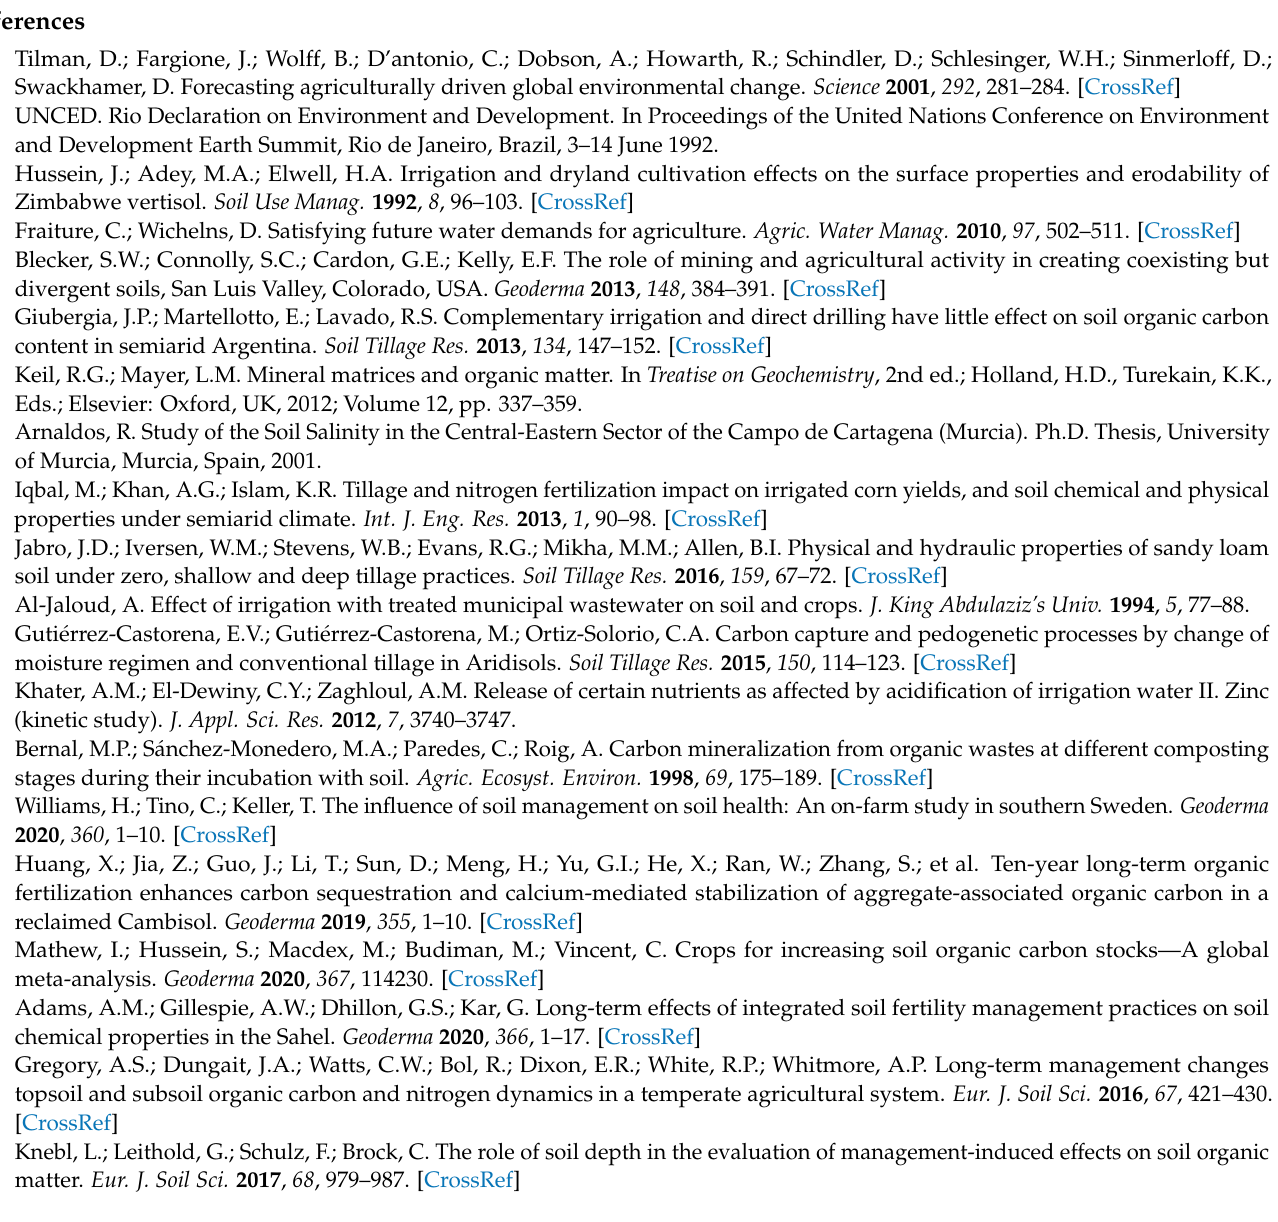
Figure A1. ( A ). Manure not yet decomposed in the Ap1 horizon and mottling of soluble salts (Ap2) of Profile 2. ( B ). Detail of carbonate mottling and oxidation-reduction mottling in the C2 horizon of Profile 2. ( C ). Detail of carbonates mottling in the C2 horizon of Profile 3.